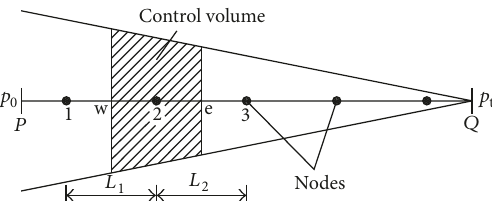
Figure 4: Dividing fluid domain into discrete control